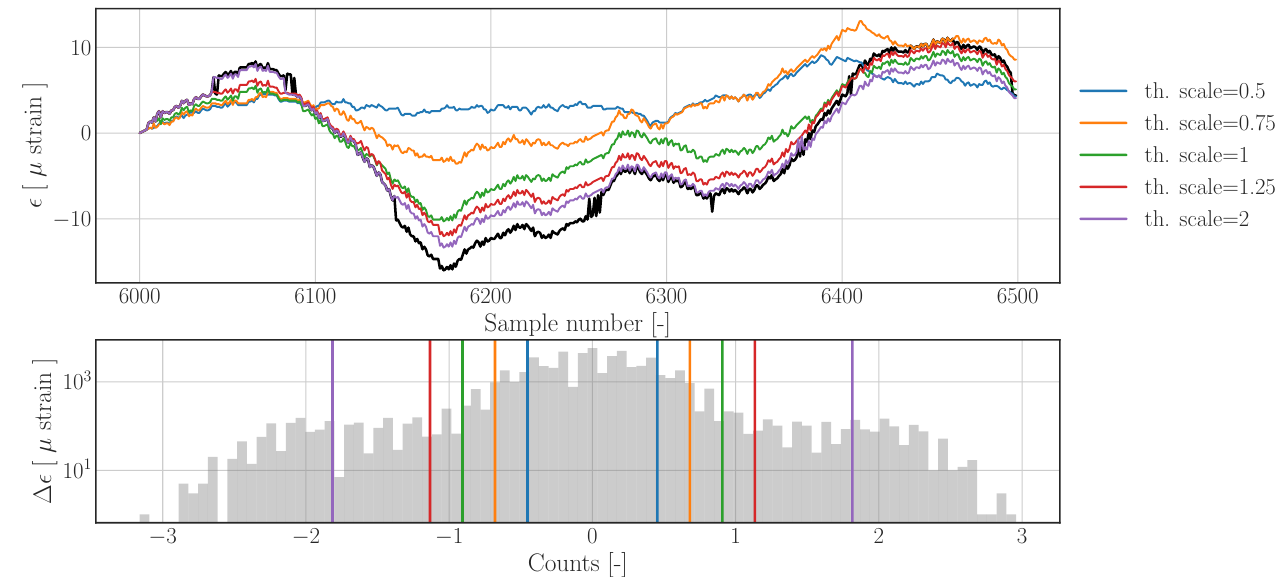
Figure 16. Sensitivity study on reconstruction results using threshold filter based method with default settings for data contained in Overlapping.hdf5 . Upper : reconstructed and raw strain time series; first sample of subset has been re-centred at zero to more clearly show the effect of drift. Lower : Histogram of the raw difference signal with vertical lines indicating the selected threshold levels which are used for the reconstruction.